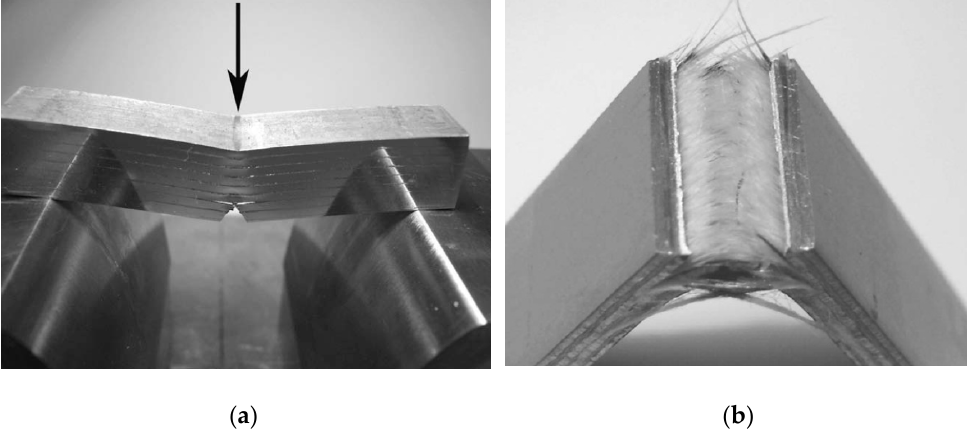
Figure 5. ( a ) Schematic view of test specimen and ( b ) fracture of GLARE specimen (reproduced with permission from [103]; copyright © 2021 Elsevier Ltd.).